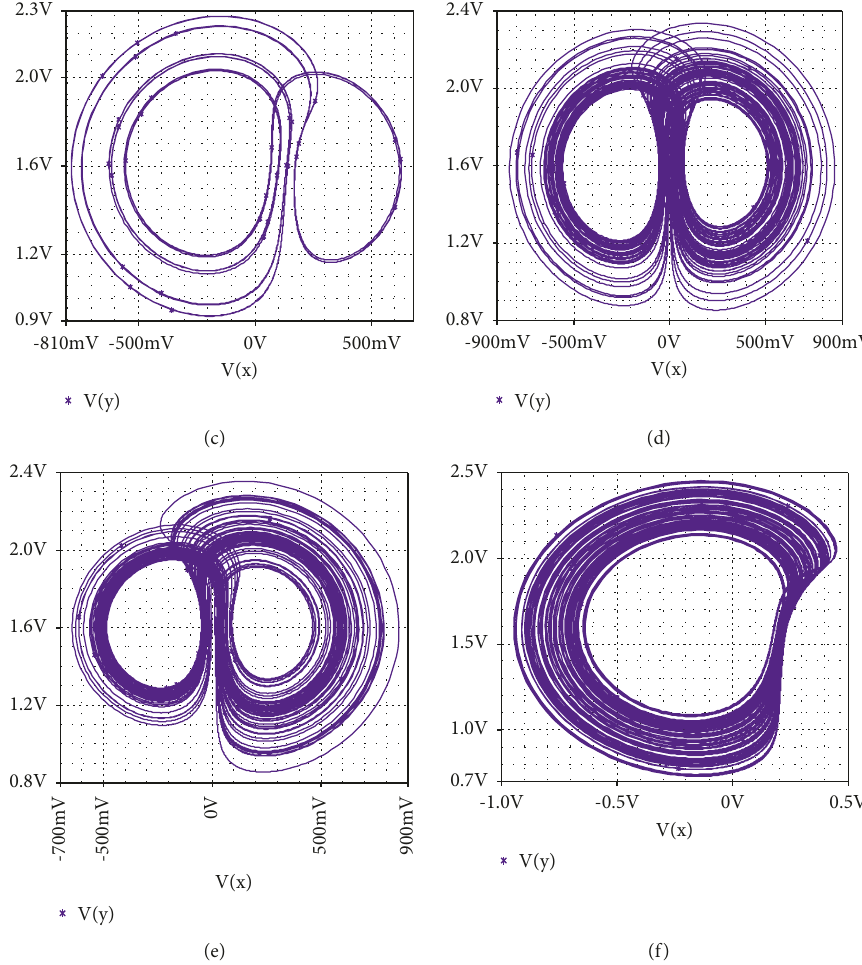
Figure 16: The phase portraits of the chaotic attractor and periodic attractor in planes ( V conditions are V x ( 0 ) � V y ( 0 ) � V z ( 0 ) � 0 . 01 V . The values of the resistors and capacitors are R R � 60 M Ω , 39 � C � C � 10 nF , V � V � V � V � 15 V R � R A : (a) period-1 attractor R A 1 2 3 7 8 9 10 40 R A � 750k Ω , (d) chaotic attractor R A � 41955.22 k Ω , (e) chaotic attractor R A � 4781k Ω , and (f) chaotic attractor R A � 480k Ω